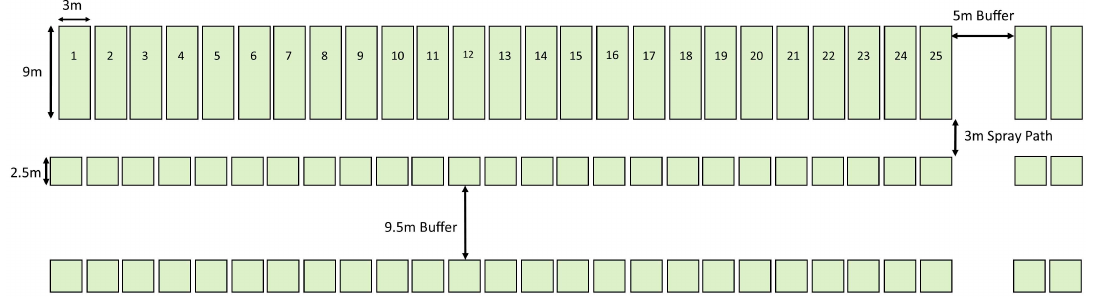
Figure 1. Layout of a single diversity experiment field planting strip, consisting of 25 plots each growing a different wheat cultivar. This layout was repeated 12 times, 3 times for each of the four different nitrogen treatments, and so the field contained 300 plots in total (with each plot consisting of a larger 9 m × 3 m “main plot”, and a 2.5 m × 3 m “sampling plot”).